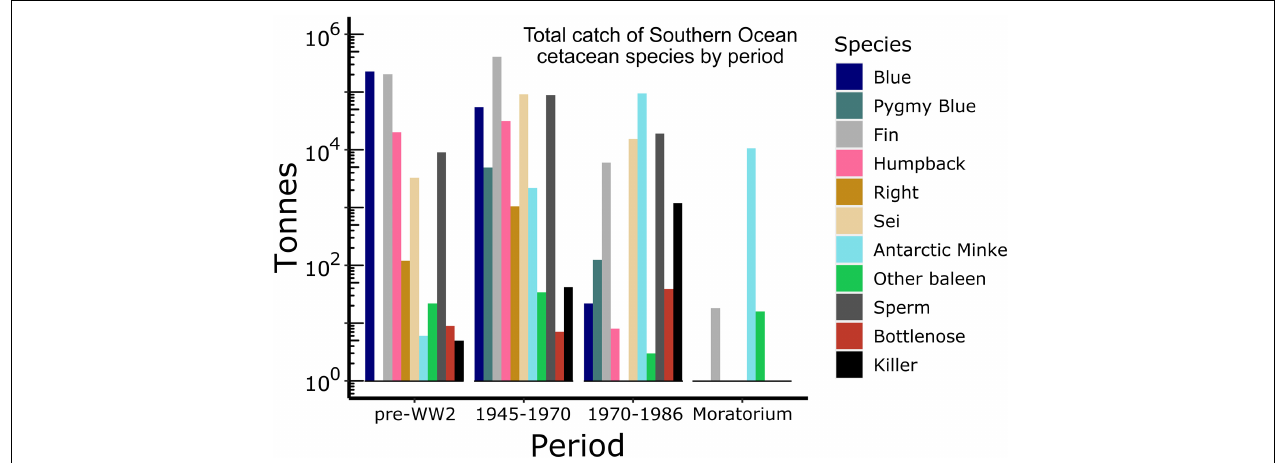
FIGURE 4 | Total catch (tonnes) of Southern Ocean cetacean species (right legend) in four different periods of whaling. Data from IWC Catch Records. Y -axis is on a log 10 scale.